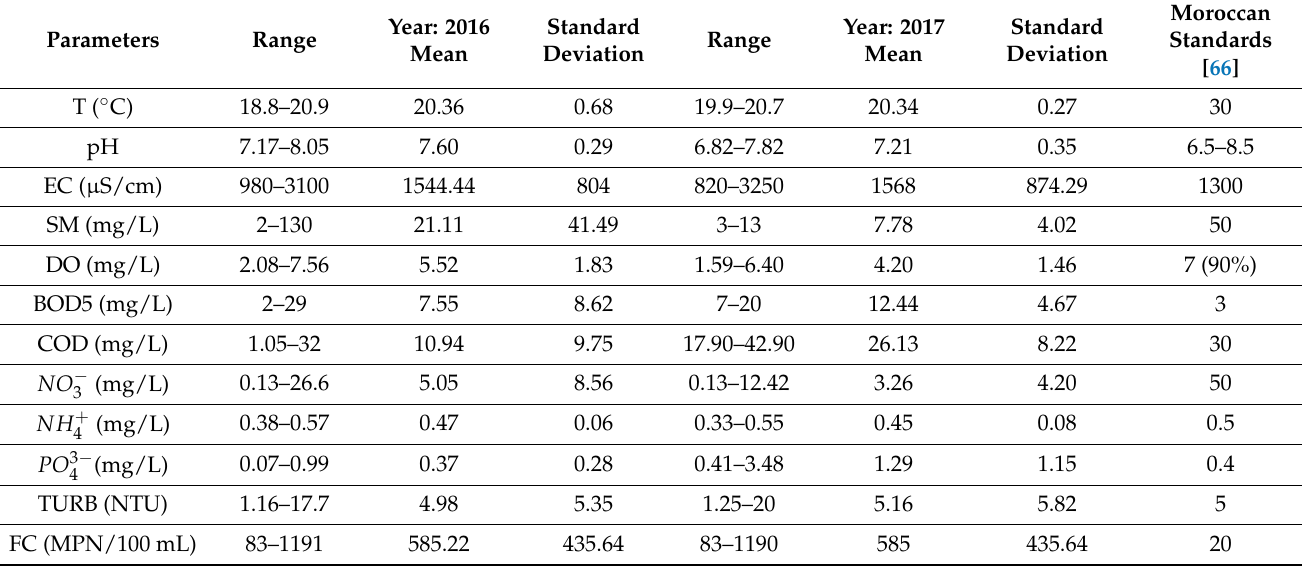
Table 9. Values of water quality parameters in 2016 and 2017 for all 9